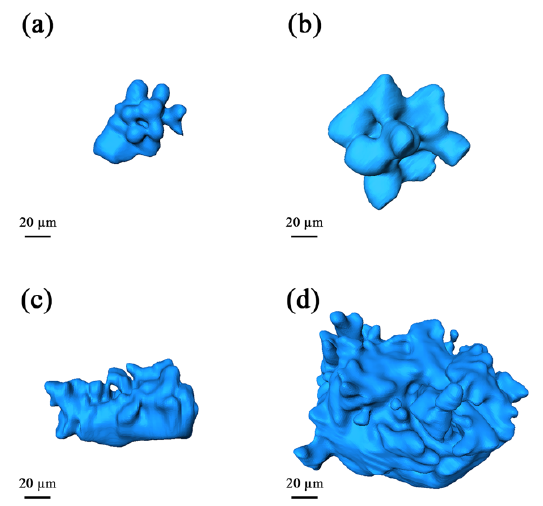
Figure 7. Three-dimensional rendering of an individual Mg grain in Mg–10Zn–6.8Gd–4Y after an isothermal heat treatment at 580 °C for different holding times: ( a ) 0 min; ( b ) 5 min; ( c ) 15 min; ( d ) 120 min.